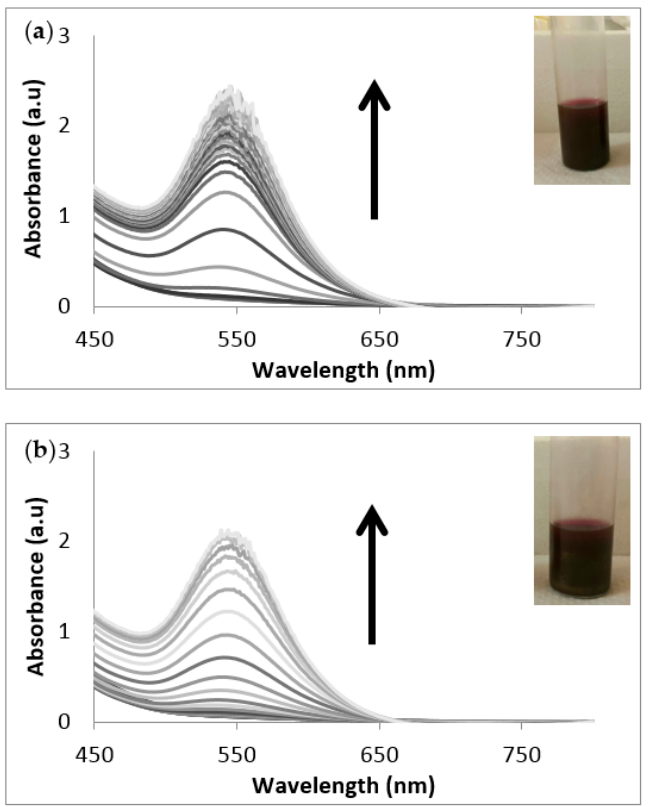
Figure 5. UV-Vis absorption spectra of ( a ) AC-AuNPs and ( b ) AR-AuNPs formed after 5 h at room temperature (in water). Inset: Photograph of the colour of the solution after 5 h. AC: Aqueous extract subjected to organic solvent partitioning. AR: simple aqueous extraction.